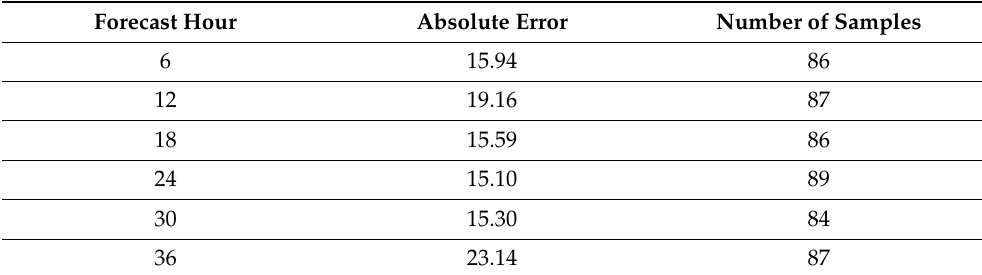
Figure 7. Comparison of near-surface wind speed (m/s) and sea-level pressure (hPa) between the MPAS forecast and observations (Tongyeong, Geojedo, and Ulsan stations) for the case of Mitag in 2019. Here, the x-axis indicates the time with the date of simulation period, and the observation data were collected at one hour intervals. Table 4. Absolute error (degree) of wind direction forecasts for 15 experiments listed in Table 2, compared to the observations collected from six stations (Geojedo, Geomundo, Marado, Seogwipo, Tongyeong, and Ulsan) shown in Figure